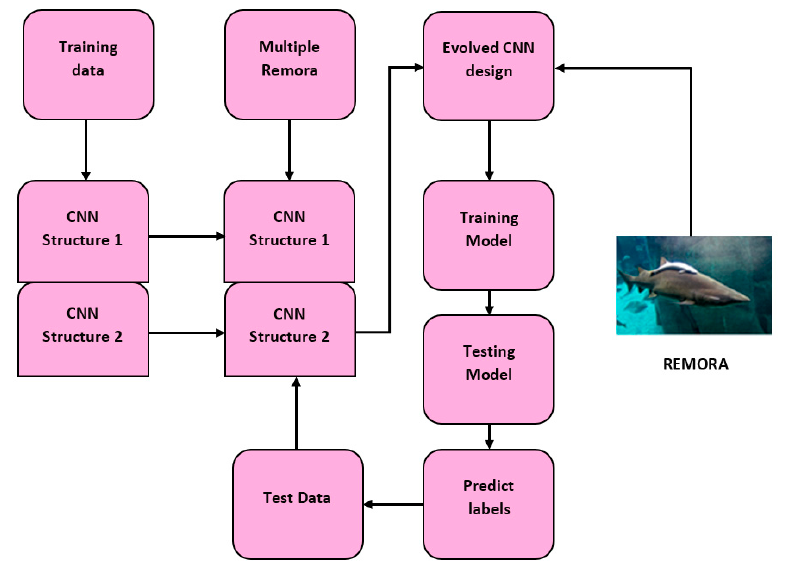
Figure 3. Process of the proposed technique.